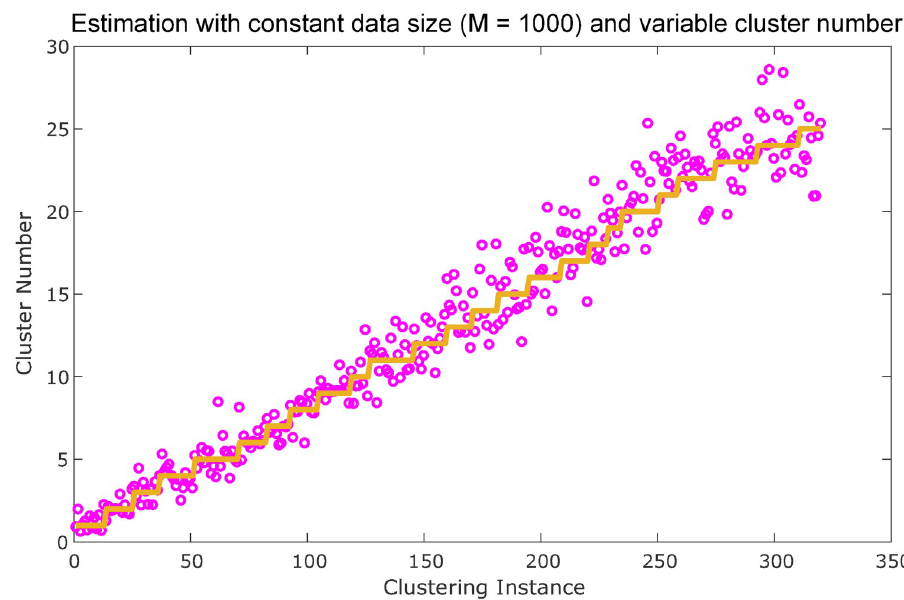
Fig 7. Cluster number estimation for constant number of data points. HLR was applied to a random set of clustering instances with variable cluster number (1 to 25), but the total number of data points was fixed at M = 1000 for all clustering instances. The plot shows the estimates of cluster number vary 1:1 with the ground-truth values, confirming HLR does not infer cluster count based on number of data points present, which is a possible confounder because the total number of data points would be expected to scale proportionally with the number of clusters